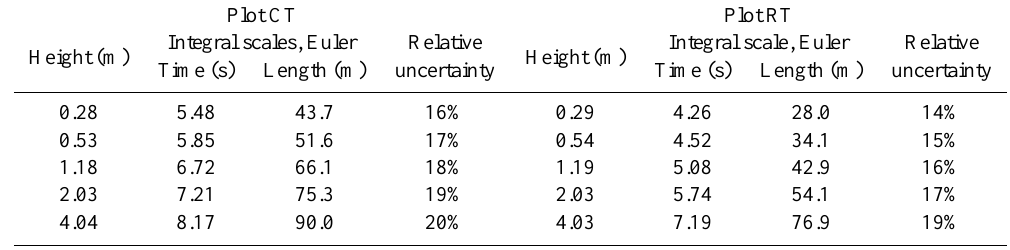
Table 3. Statistical atmospheric uncertainty of the second moment (variance) for a Gaussian probability distribution. The integral scales stem from a previous study relating to the same experiment (Yahaya et al., 2003).